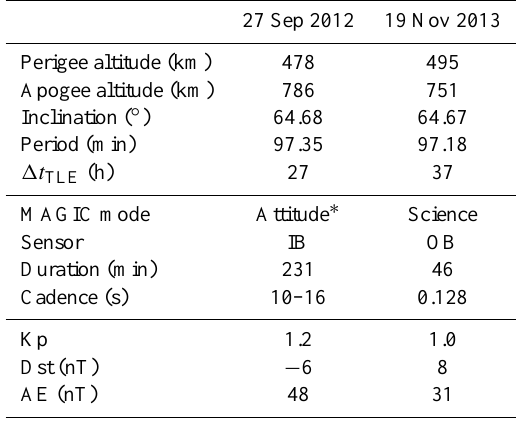
Table 1. Summary of the MAGIC data used in this paper including the orbital elements of CINEMA, MAGIC modes and geomagnetic indices.